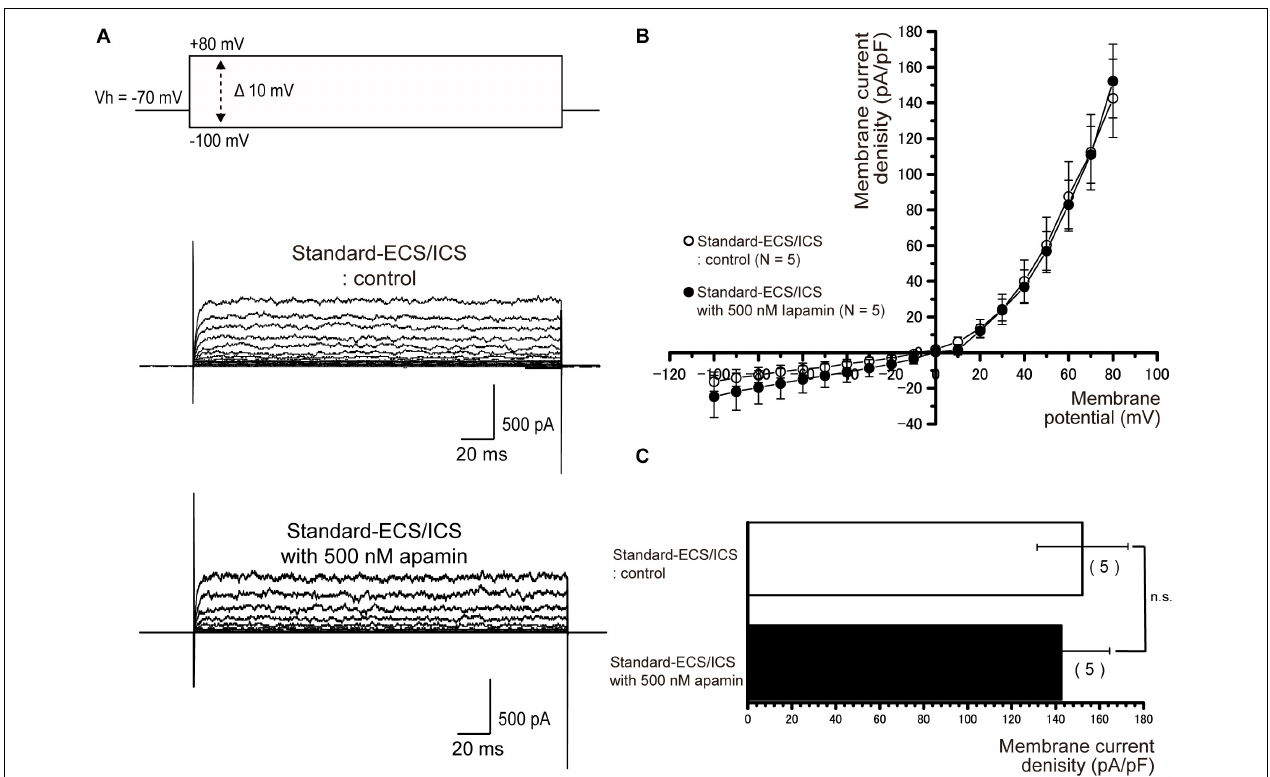
FIGURE 7 | Apamin had no effects on the outward currents. (A) Representative current traces recorded under standard-ECS/ICS conditions without (second upper traces) and with the application of 500 nM apamin (third upper traces) are shown. Currents were evoked by applying (400 ms) voltage in 10 mV increments from –100 mV to +80 mV at a holding potential (Vh) of –70 mV (upper traces). (B) Current-voltage (I-V) relationships for the currents recorded under standard-ECS/ICS conditions without (open circles) and with the application of 500 nM apamin (filled circles) are shown. Each point represents the mean ± SE current density of five cells. (C) Summary bar graphs showing current densities under standard-ECS/ICS conditions at a membrane potential of +80 mV without (upper column) and with the application of 500 nM apamin (lower column). Each column indicates the mean ± SE of five